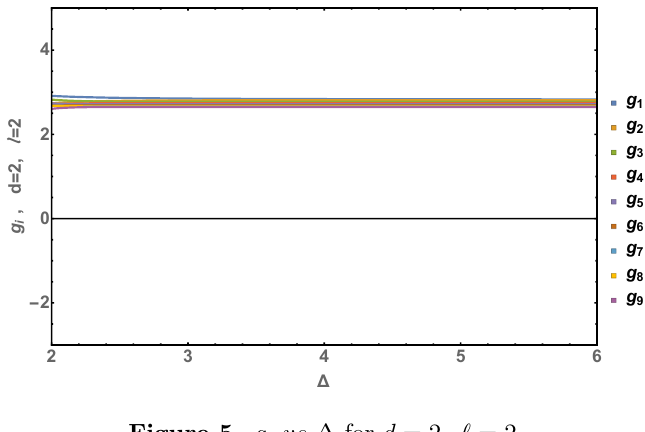
Figure 5. g i vs (cid:1) for d = 2 ; ‘ =